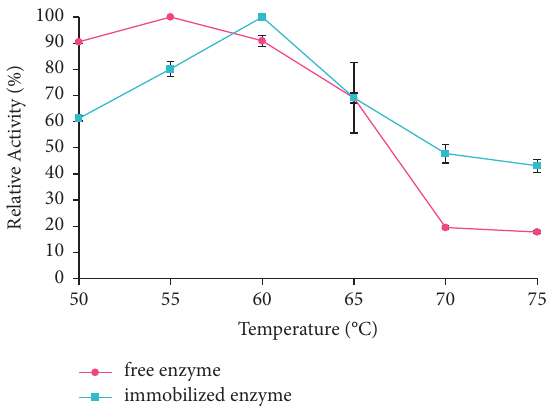
Figure 4: The optimum temperature of the free and immobilized enzymes. The data are presented as mean ± SD; n � 2; p ≤ 0 . 05. The error bars represent standard deviations from two replicates